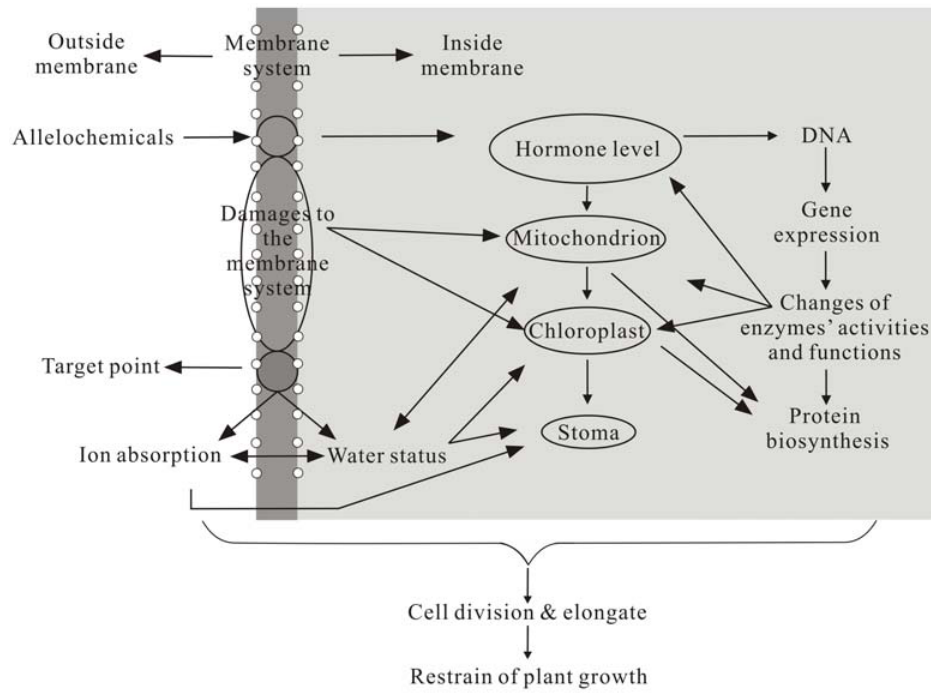
Figure 8. Mechanism of allelochemicals